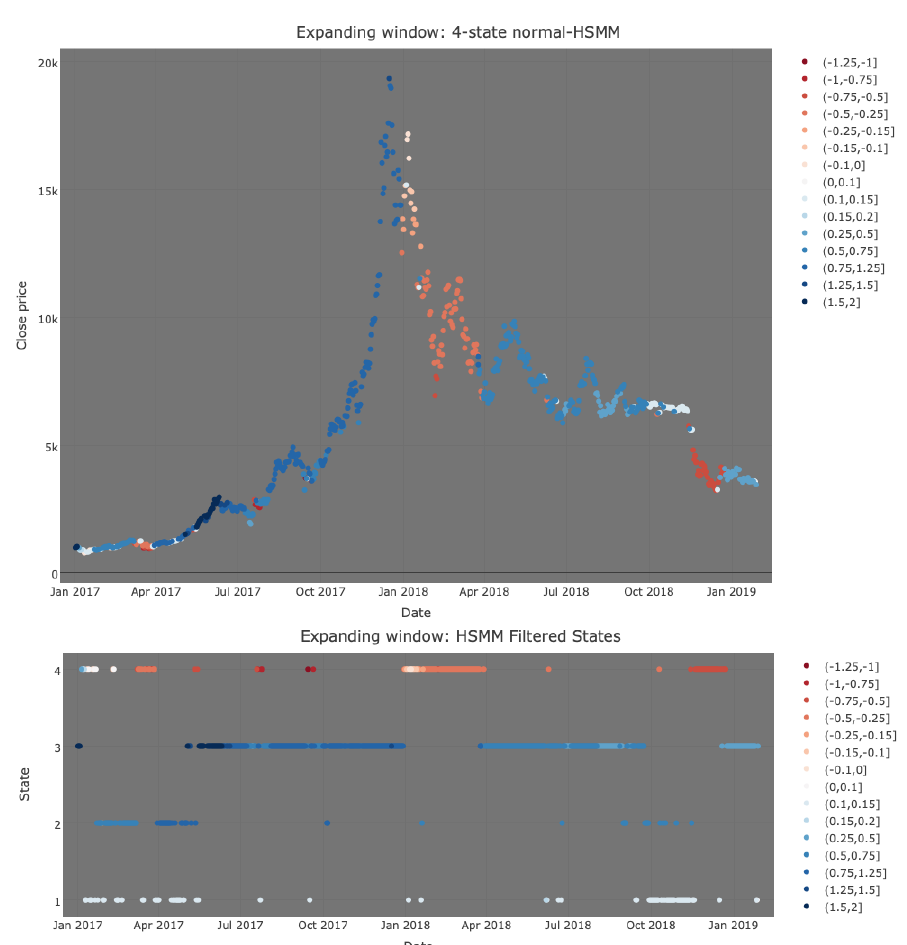
Figure 8. Expanding window: four-state normal HSMM filtering via the Viterbi algorithm on BTC/USD. Upper figure: Colours vary by the value of the state-dependent mean (see legend), and the larger the state-dependent volatility, the larger the dot size. Lower figure: The plot indicates the inferred state at each time point, and the colour code also indicates the value of the state-dependent mean as per the legend. Figure reproduced from